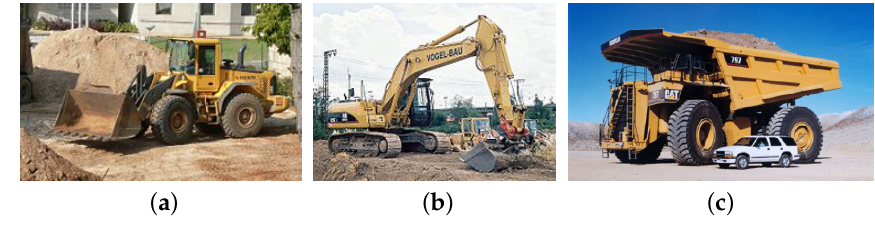
Figure 1. Common types of heavy machines. ( a ) Loader; ( b ) excavator; ( c )